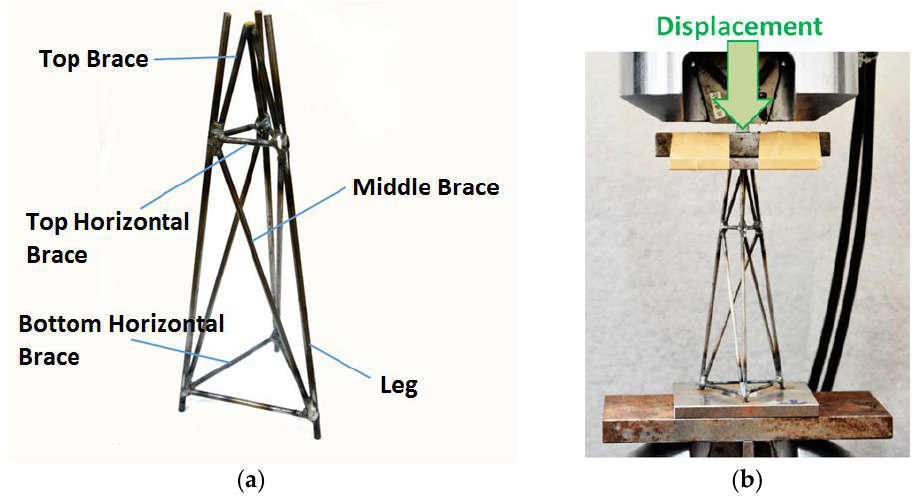
Figure 2. ( a ) Schematic of a scaled-down test specimen of the MJ0-structure; ( b ) snapshot of the experimental setup.